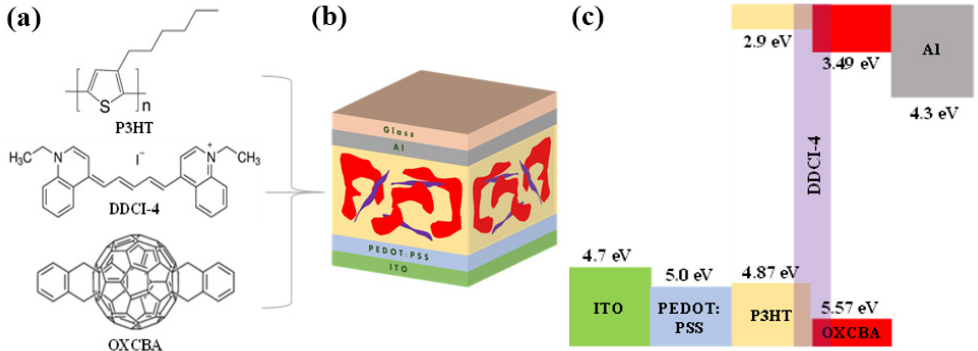
Figure 1. ( a ) Molecular structure of P3HT, DDCI-4, and OXCBA; ( b ) Schematic diagram of photodiode architecture; ( c ) Schematic energy level of active materials.